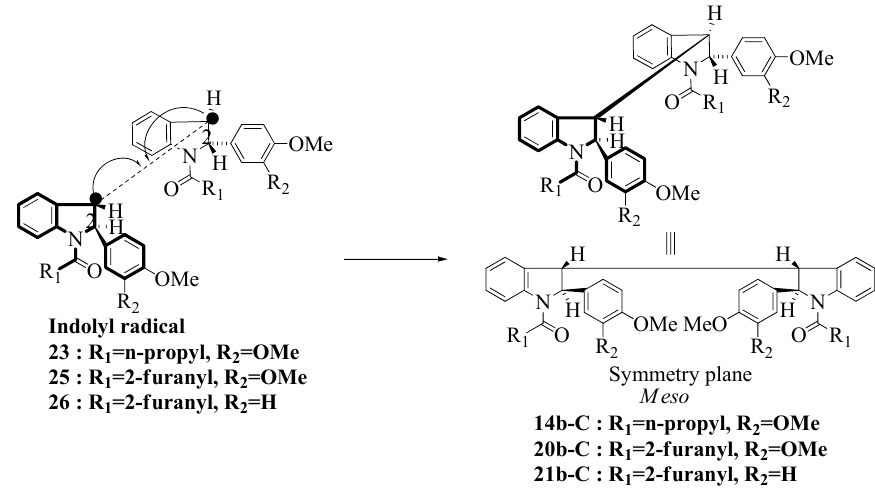
Scheme 6. Dimerization pathways leading the stereoisomers 14b-C , 20b-C and 21b-C.